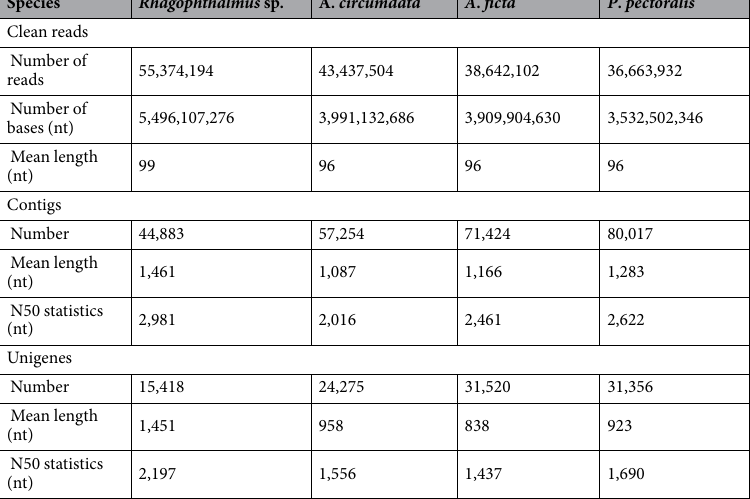
Table 1. Statistics of clean reads, assembled contigs and unigenes of the four transcriptomes generated in this study. Abbreviation: nt,